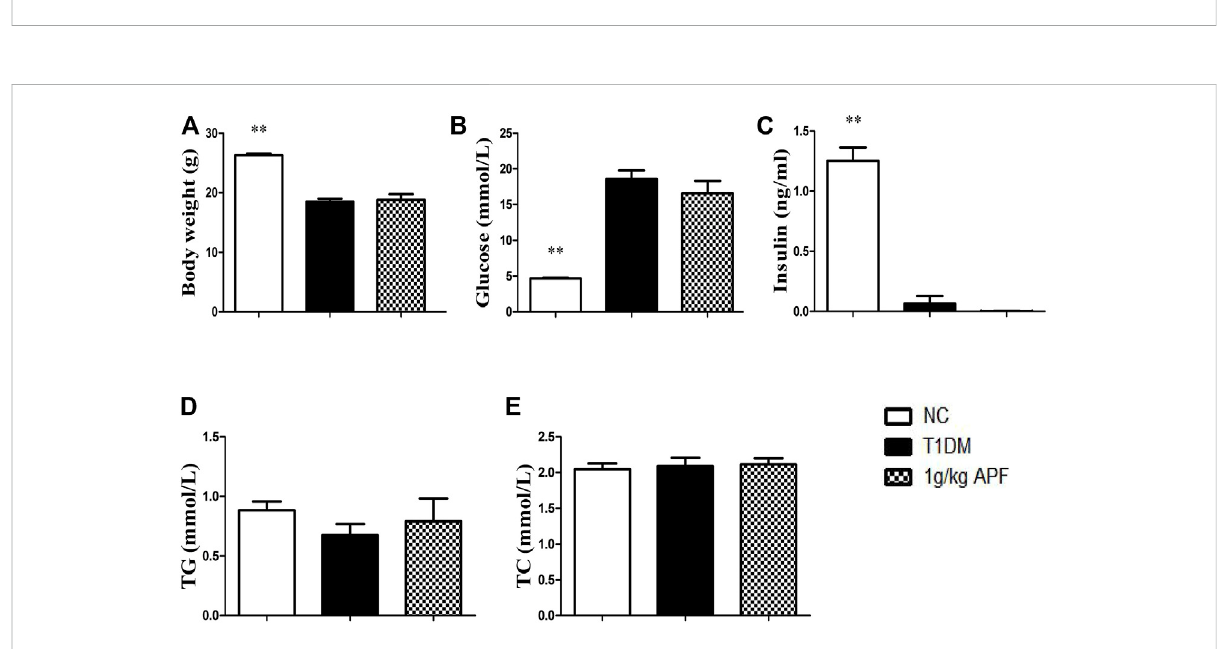
FIGURE 7 Effects of APF in T1DM mice. Body weigt (A) , plasma glucose (B) , insulin (C) , TG (D) and TC (E) of normal control (white bars), type 1 diabetes group (black bars) and APF group (grid bars) after treatment with APF 6 weeks. Values are means ± SEMs, n = 6 – 10 per group. * p < 0.05, ** p < 0.01 versus T1DM